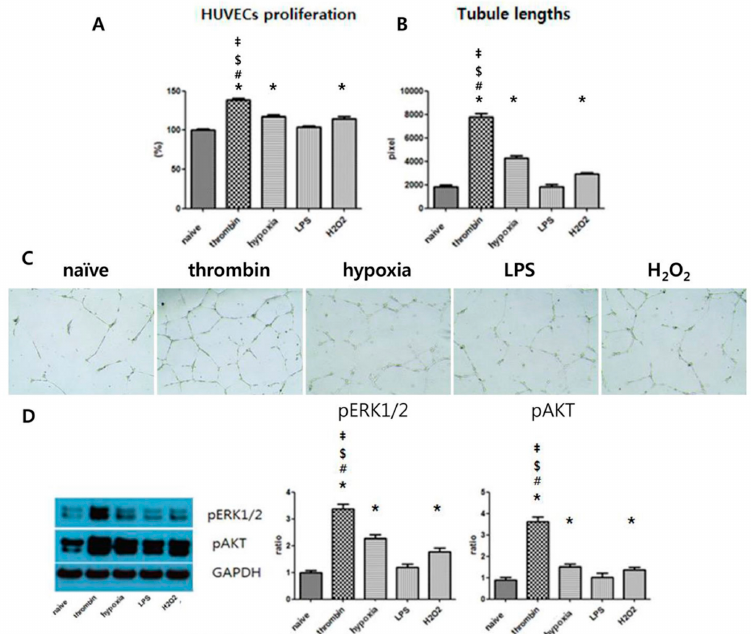
Figure 5. The promotion of proliferation and angiogenesis of HUVECs with stimulation by EVs. ( A ) Proliferation rates of HUVECs following treatment with naïve and thrombin-, 10% O2-, LPS-, and H 2 O 2 -treated EVs for 24 h. HUVECs were cultured on Matrigel with a medium containing naïve MSC-EVs, thrombin-treated (40 U) EVs, 10% O 2 -treated EVs, LPS-treated (1 µ g) EVs, or H 2 O 2 -treated (50 µ M) EVs. ( B ) Quantitation of pixels and ( C ) representative photomicrographs ( × 100). ( D ) Lysate from HUVECs treated with EVs for 24 h subjected to Western blot analysis. Cell lysate was analyzed by immunoblotting and normalized to GAPDH, and the ratio of densitometry to GAPDH is shown beneath the blots. Data are presented as mean ± SEM Statistical analyses were carried out using a One-way Analysis of Variance (ANOVA). The asterisk (*) indicates p < 0.05 compared with naive EVs, the number sign (#) indicates p < 0.05 compared with the 10% oxygen-treated EV group, the double dagger ( ‡ ) indicates p < 0.05 compared to the H 2 O 2 -treated EV group, and the dollar sign ($) indicates p < 0.05 compared with the LPS-treated EV group ( n = 5 per each